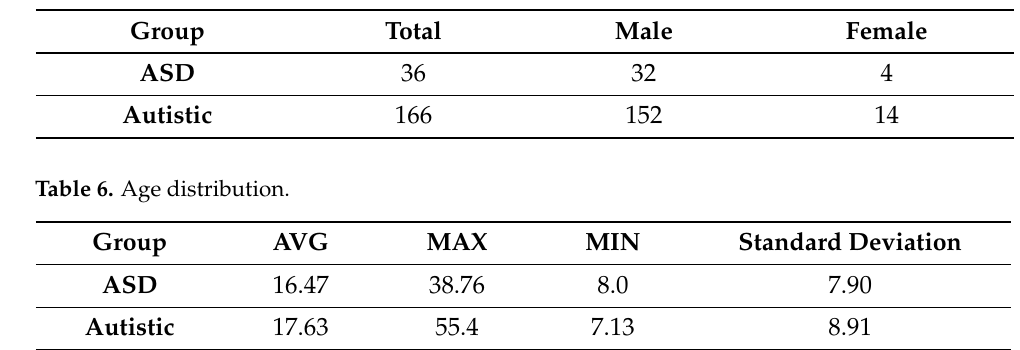
Table 5. Sex distribution.